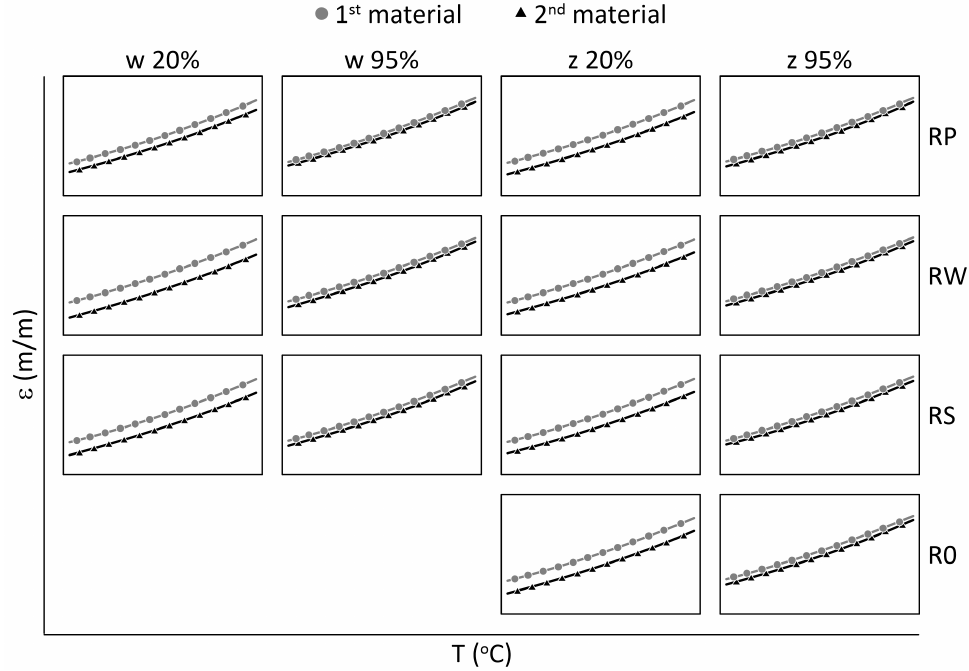
Figure 14. A comparison of strain trends for M3 X (First Material) and M3 Crystal (Second Material) samples under sub-zero